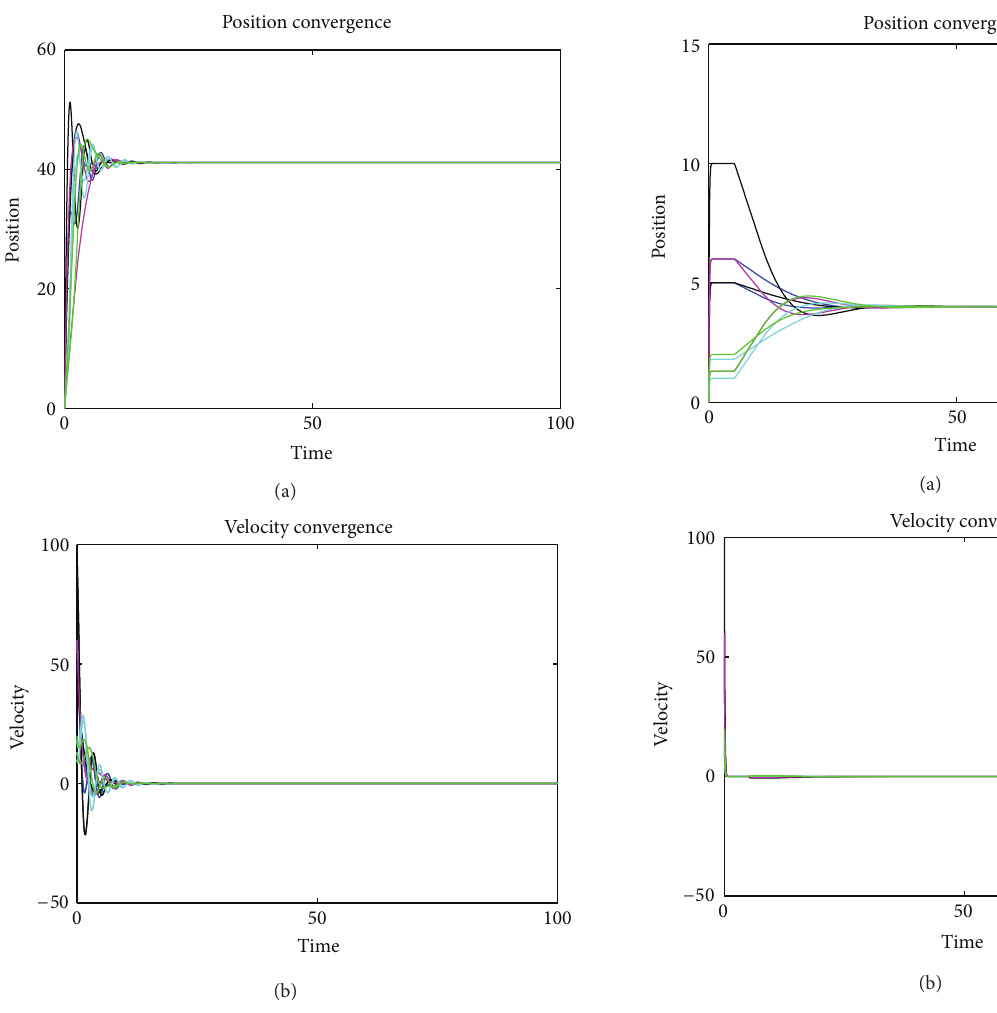
Figure 3: The consensus in system (35) with the general topology as 𝜏 = 5, 𝛾 = 10